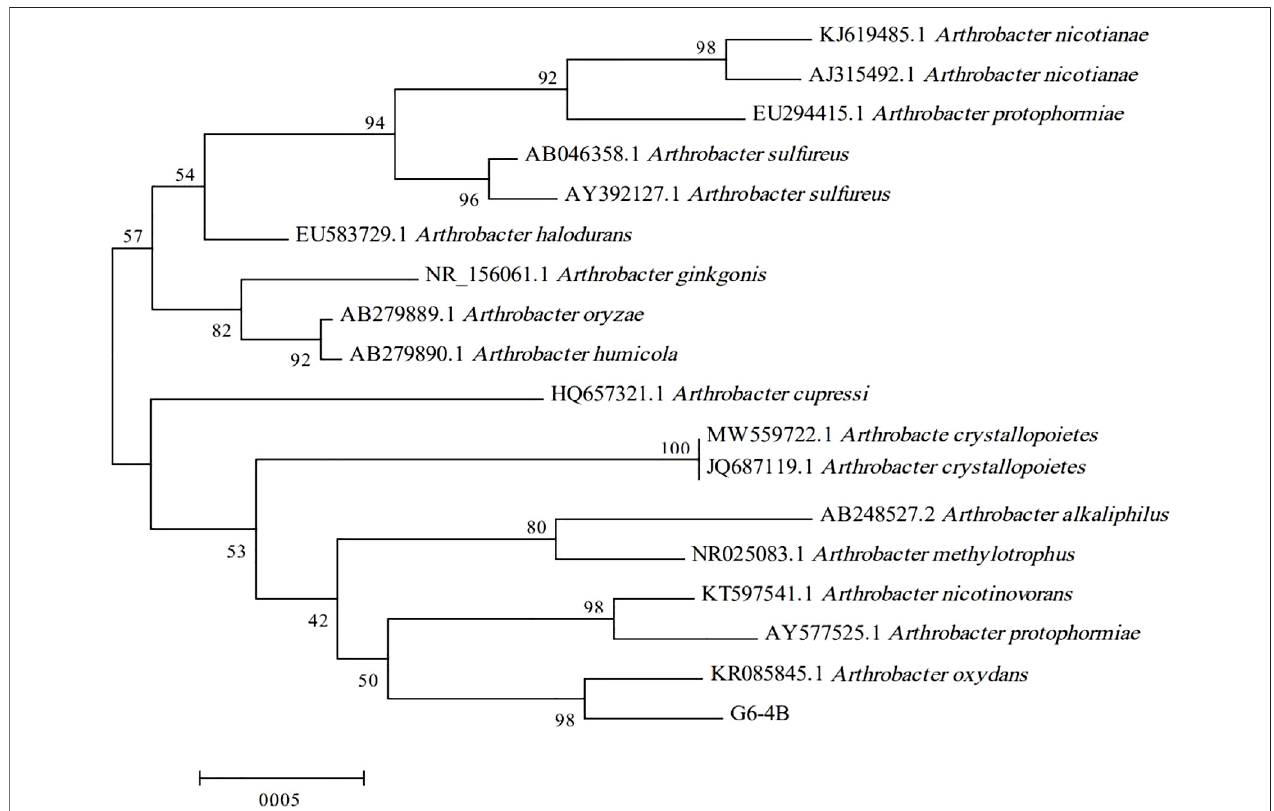
FIGURE 2 | Phylogenetic tree based on 16S rDNA gene